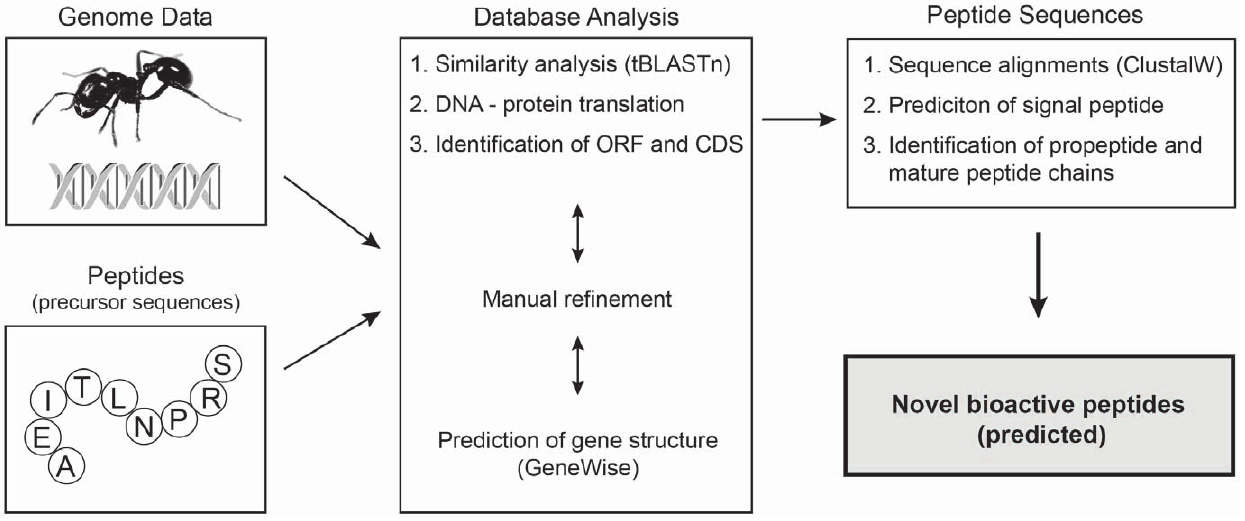
Figure 1. Flowchart of genome-mining for the discovery of ant peptides used in this study. Whole genome shotgun data, in this instance from the three ant species Atta cephalotes , Camponotus floridanus and Harpegnathos saltator , and amino acid sequences of precursor proteins from bioactive peptides of interest ( e.g. defense and/or regulatory neuropeptides) were used for database analysis. This included similarity analysis of target DNA sequence and query protein sequence using tBLASTn, DNA to protein translation of discovered hit sequences and identification of open reading frames and coding sequence. The obtained automated results were refined and confirmed manually and used for gene structure prediction using the GeneWise algorithm. Database analysis yielded precursor protein and peptide sequences that were further annotated and analyzed by sequence alignments and similarity comparison to identify signal sequences, propeptides and mature peptide chains. Using this genome-mining methodology it was possible to predict the amino acid sequences of bioactive peptides in